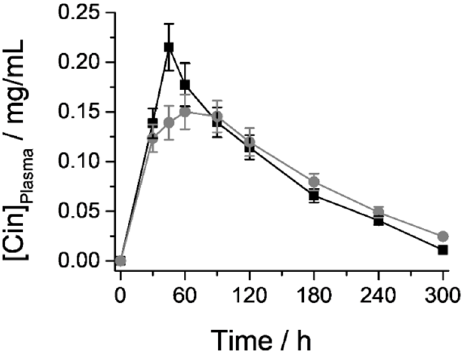
Figure 12. Cinnamaldehyde ( Cin ) concentrations in plasma and after oral administration of a dose of 13,6 mg Cin in the different formulations: free (black (cid:4) ) or encapsulated into the M41-Cin-L microdevice (gray • ). The number of individues in the groups were n = 6 up to 120 min, and n = 3 up to 240 min. Provided data represent data average, and error bars represent the standard deviation. Table 3. Pharmacokinetic parameters calculated from plasma samples after oral administration of a Cin dose of 13.6 mg both free and encapsulated into M41-Cin-L microdevice. % Parameter Cin Free M41-Cin-L